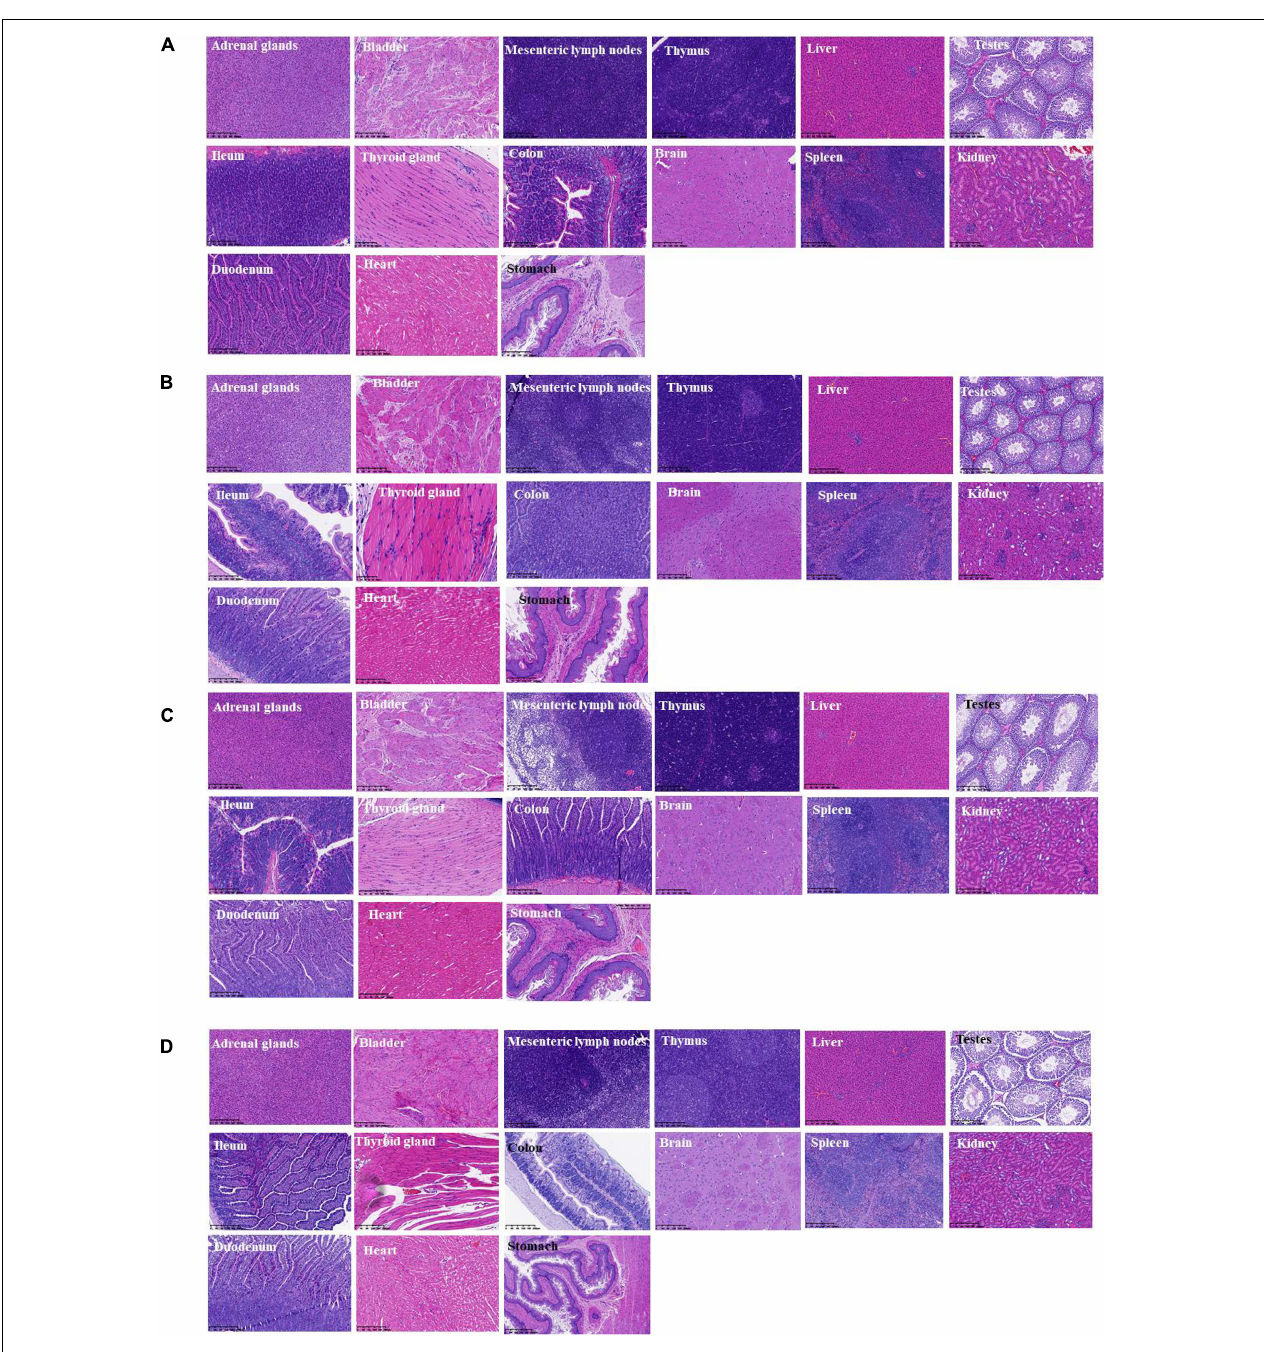
FIGURE 6 | Histopathological detection of feeding rats on 28-day acute oral toxicity study. (A) BL-99 group; (B) K56 group; (C) ET-22 group; (D) PBS